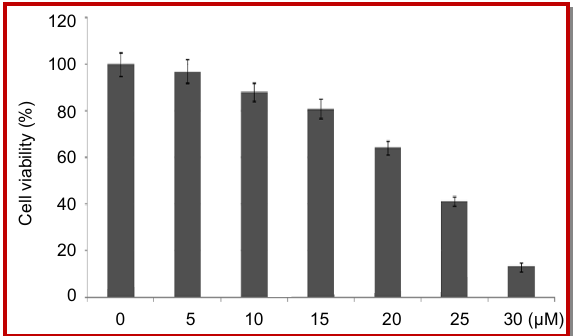
Figure 3: Inhibition of H3922 breast cancer cell viability by bry- ostatin I. The cells were treated with 5, 10, 20, 25 and 30 µM concentration of bryostatin I or with DMSO alone for 48 hours followed by viability analysis using MTT assay. The experi- ments for each of the concentration were performed in tripli- cates